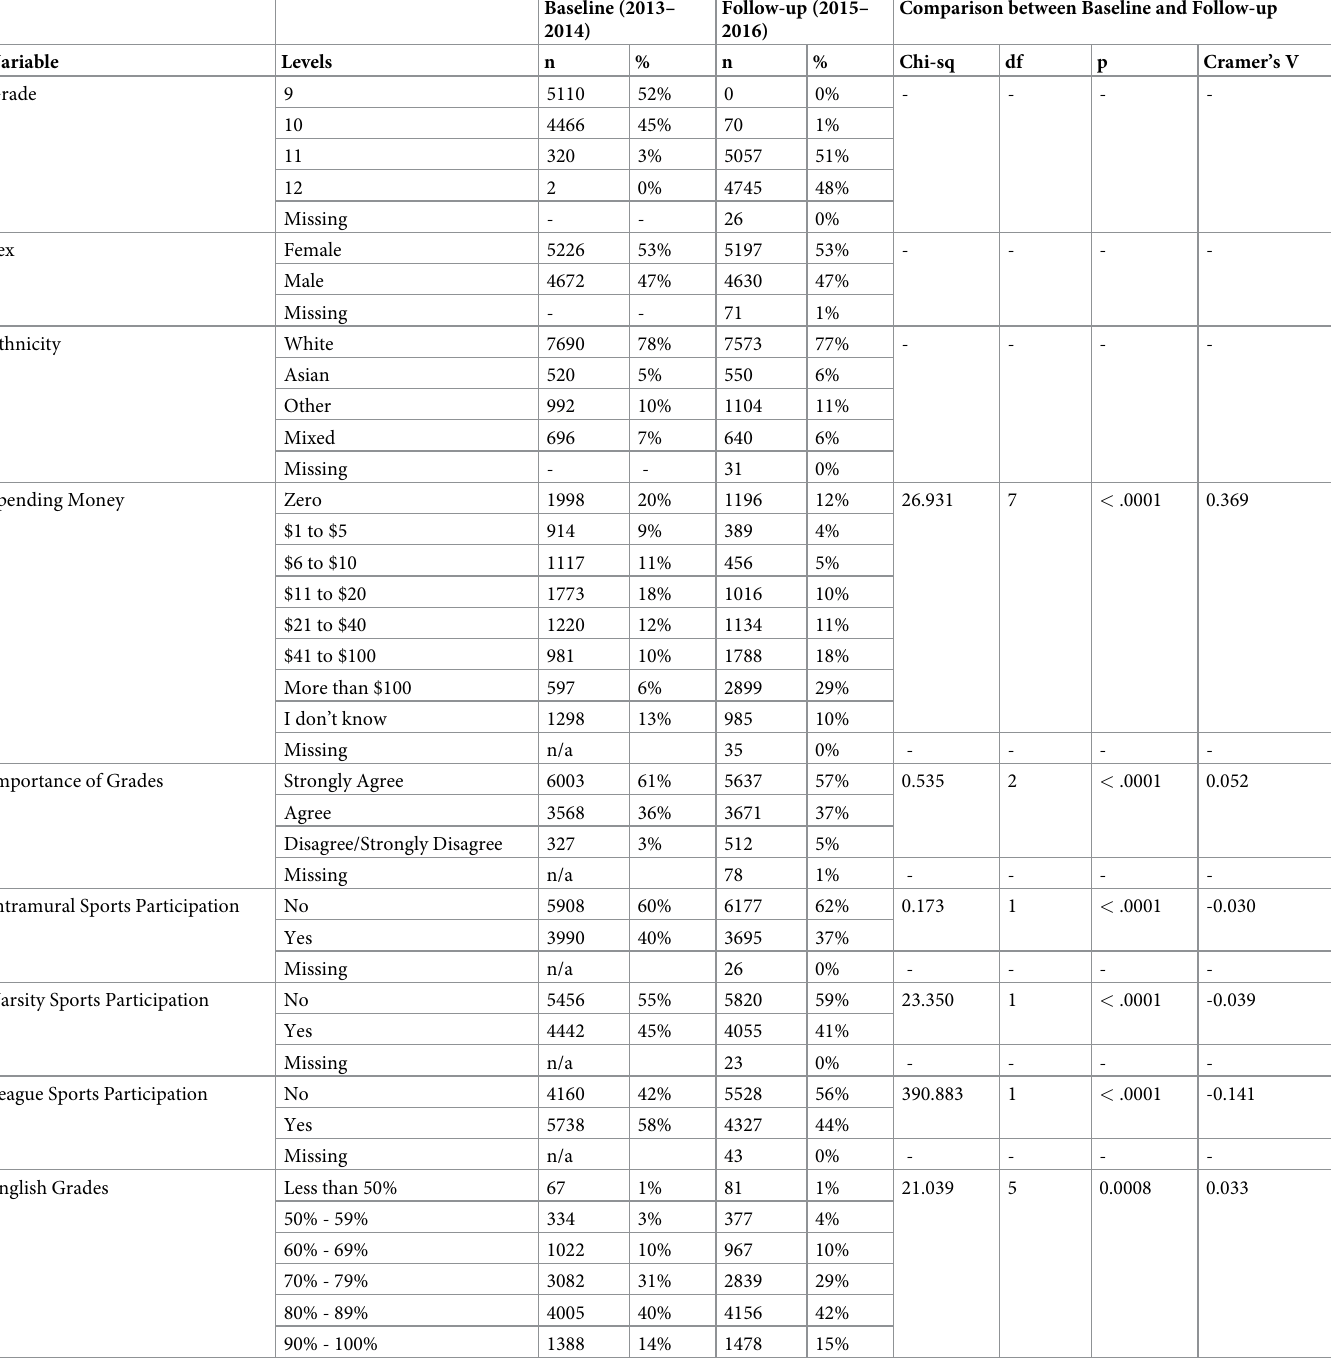
Table 1. Baseline descriptive characteristics and comparisons of 9898 linked participants from the COMPASS study: Ontario and Alberta, Canada (2013-2014/